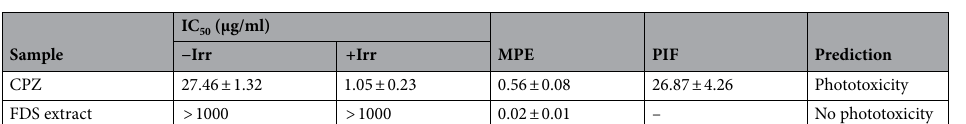
Table 3. The half-maximal inhibitory concentration (IC 50 ), mean photo effect (MPE), and photo-irritation- factor (PIF) values of chlorpromazine hydrochloride (CPZ) and the F. dubia sap (FDS) extract from the 3T3 neutral red uptake phototoxicity test. MPE and PIF data represent the mean ± SD of three independent assays. The experiments were conducted in triplicate. −Irr; non-UV irradiated conditions and +Irr; UV irradiated